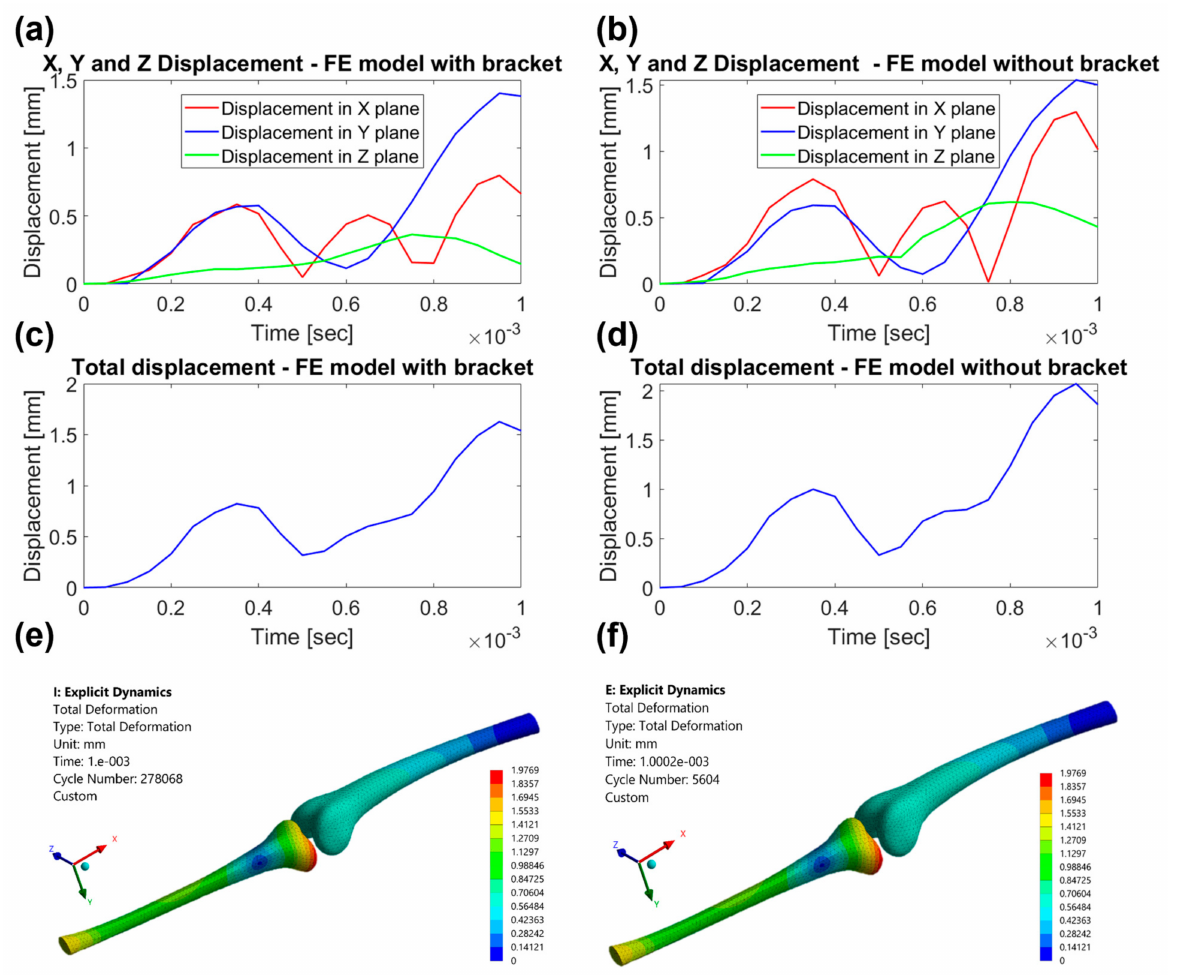
Figure 6. Evaluation of the distance between the points that represent the ACL insertion on the bone during the impact. ( a ) Displacement [mm] along the X, Y, and Z axes between the ACL insertion points for the FE model with bracket. ( b ) Displacement [mm] along the X, Y, and Z axes between the ACL insertion points for the FE model without bracket. ( c ) Total displacement [mm] between the ACL insertion points for the FE model with bracket. ( d ) Total displacement [mm] between the ACL insertion points for the FE model without bracket. ( e ) Total displacement map [mm] for the limb model with the bracket, and ( f ) total displacement map [mm] for the limb model without the bracket. Skin, bracket, and connection elements are